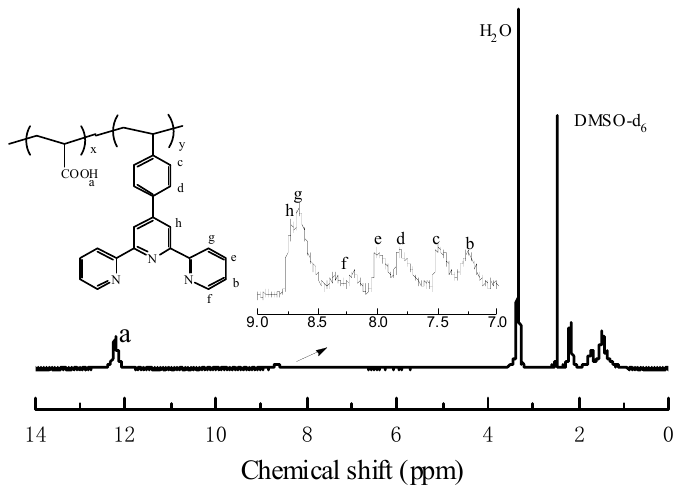
Figure 1. 1 H NMR spectra of the copolymer P(AA-co-TPY).